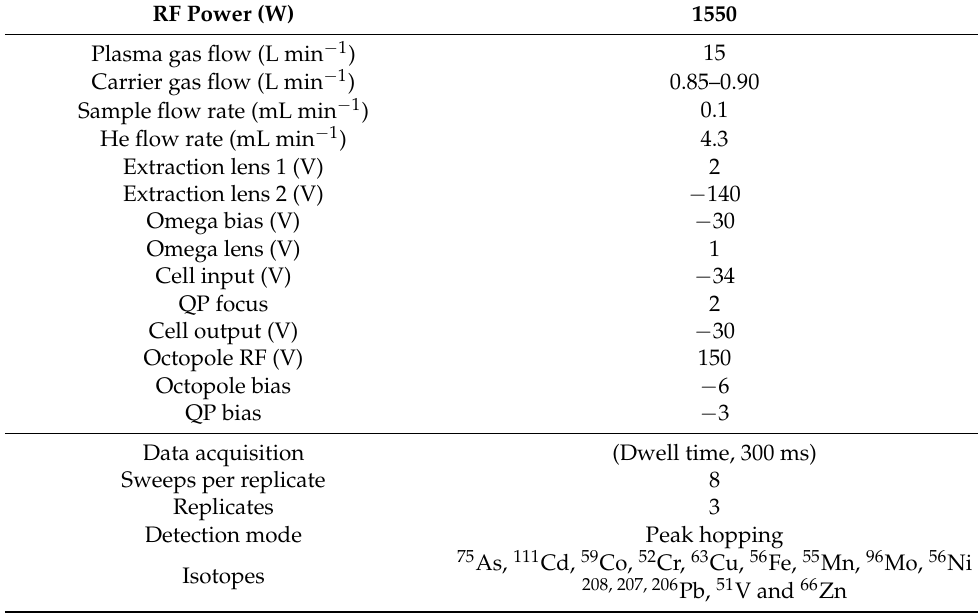
Table 1. ICP-MS operating and acquisition parameters.